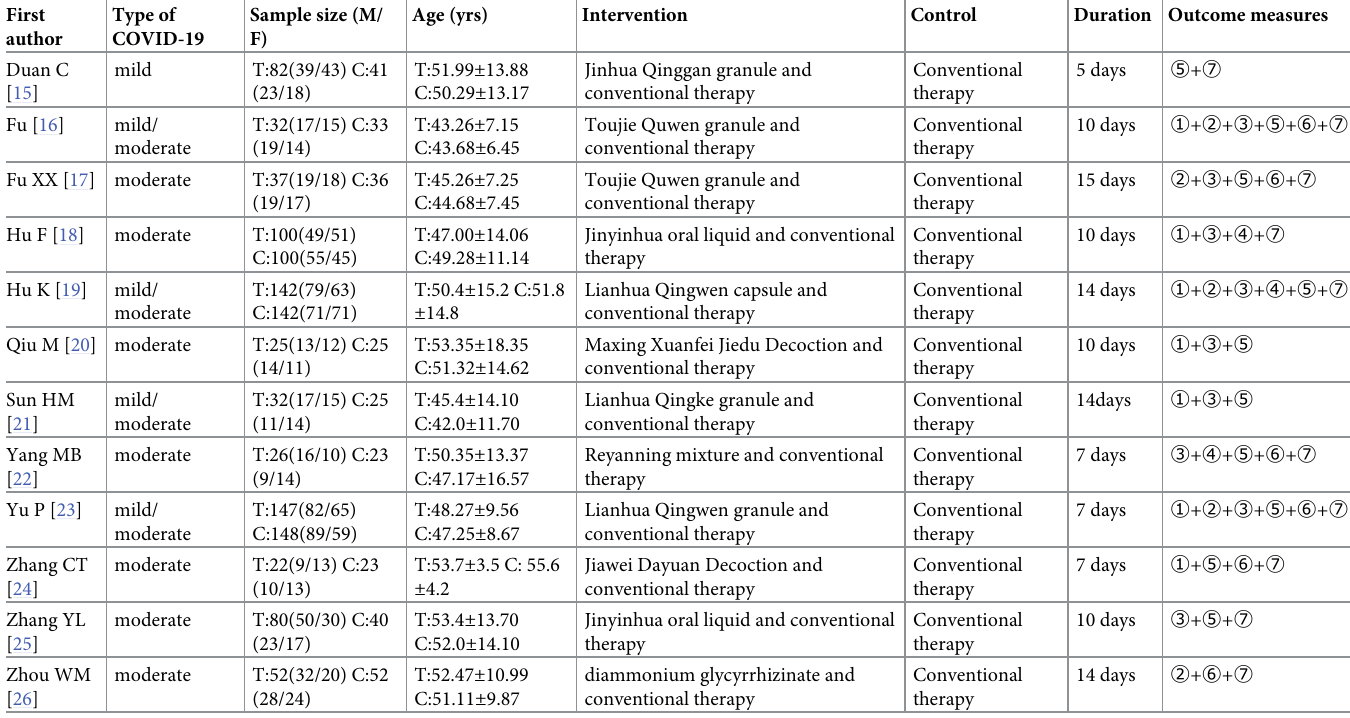
Table 1. The characteristics of included